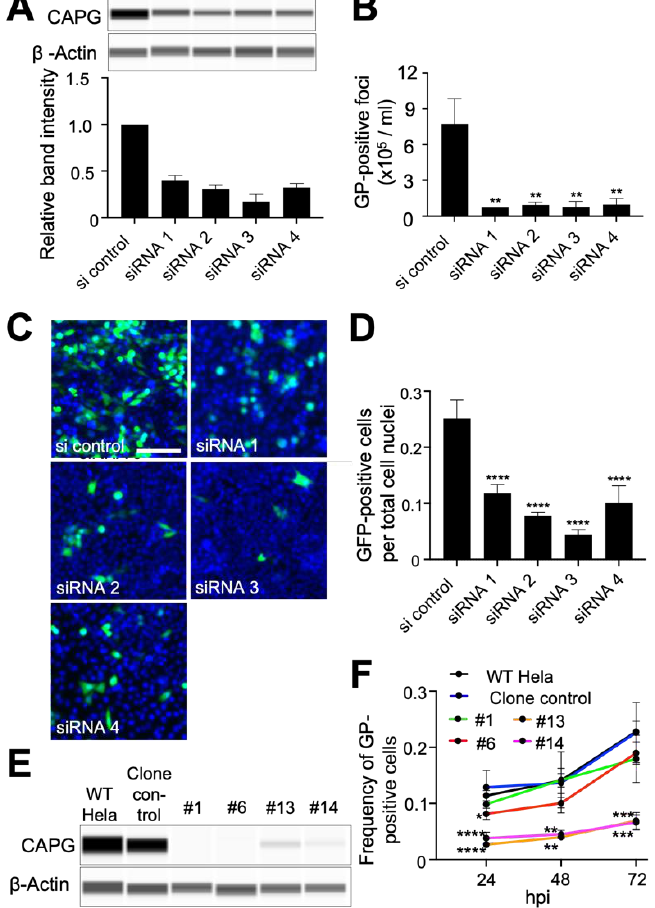
Figure 1 . Suppression of CAPG impairs EBOV infection. ( A ) CAPG knockdown (KD) was confirmed by immunoblot assay. Four siRNA targeting different regions of human CAPG were transfected into Hela cells at 40 nM. After 48 h, cells were challenged with virus and a replicate set were lysed for protein expression analysis by immunoblot (a representative blot is shown). β -actin was used as a loading control. Band intensity from triplicate samples was calculated using ImageJ, and normalized to the β -actin loading control. ( B ) Yield of infectious particles in the supernatant was measured by counting GP positive foci on VeroE6 cells. Cells were inoculated with the supernatant from wild-type EBOV-infected cells by limiting dilution. At 48 h after inoculation, cells were fixed and stained with anti-GP antibody and foci counted. ( C ) siRNA treated cells were challenged with GFP-EBOV with representative images shown from 48 hpi. Infected cells expressing GFP (green) and nuclei stained with Hoechst 33342 (blue) are visible. Scale bar = 500 µ m. ( D ) Count of GFP-positive